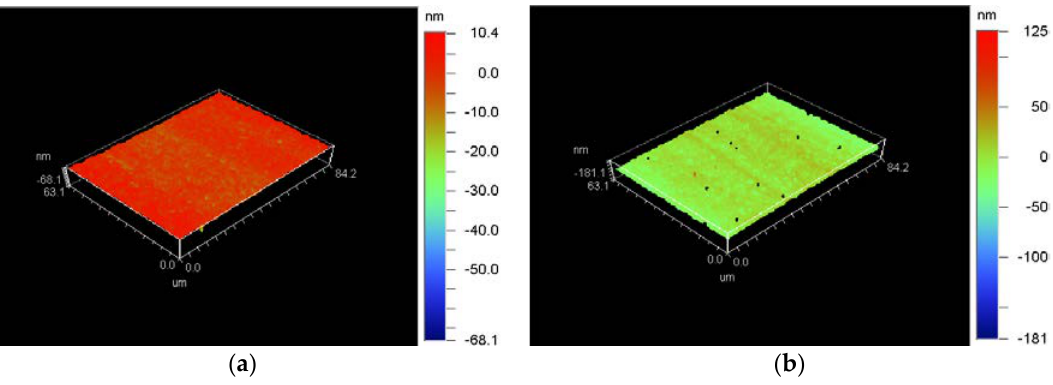
Figure 12. Surface topography of the machined workpiece after cutting along X -axis with a distance of 1 mm by a diamond tool with tip radius of 0.5 mm; ( a ) Ra 2.55 nm when diamond tool cutting in a very short distance; ( b ) Ra 8.85 nm when diamond tool cutting in a distance of 1 mm.